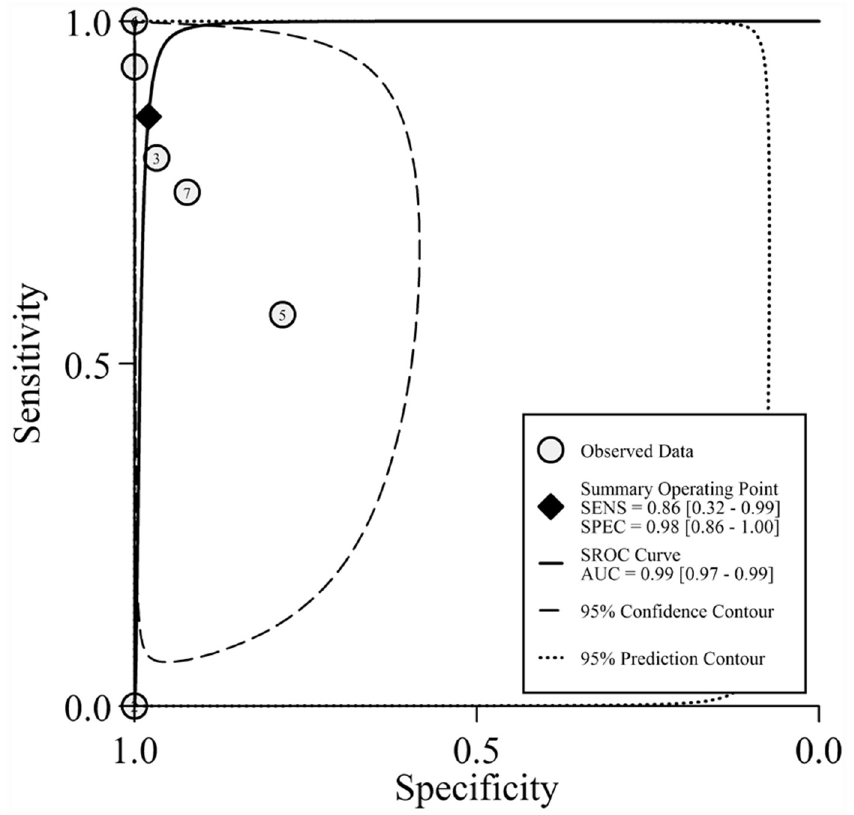
Fig 3. SROC curve with confidence and prediction regions around overall operating sensitivity and specificity point